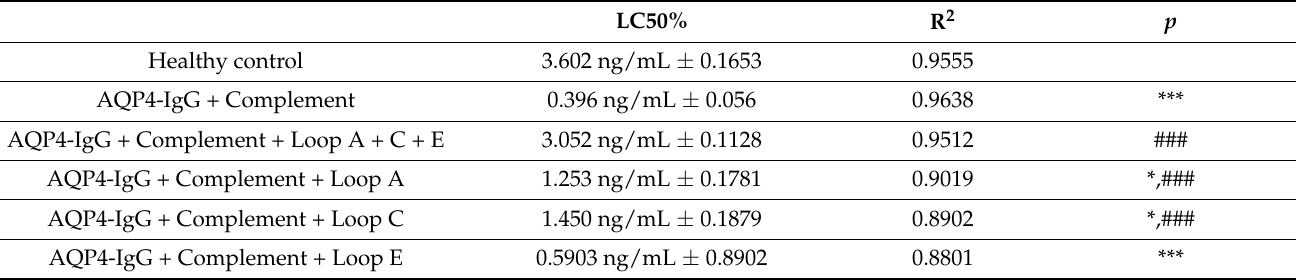
Table 1. AQP4 mimotope peptides reduced the complement-dependent cytotoxicity produced by AQP4-IgG from patient serum. LC50% R 2 p Healthy control 3.602 ng/mL ±